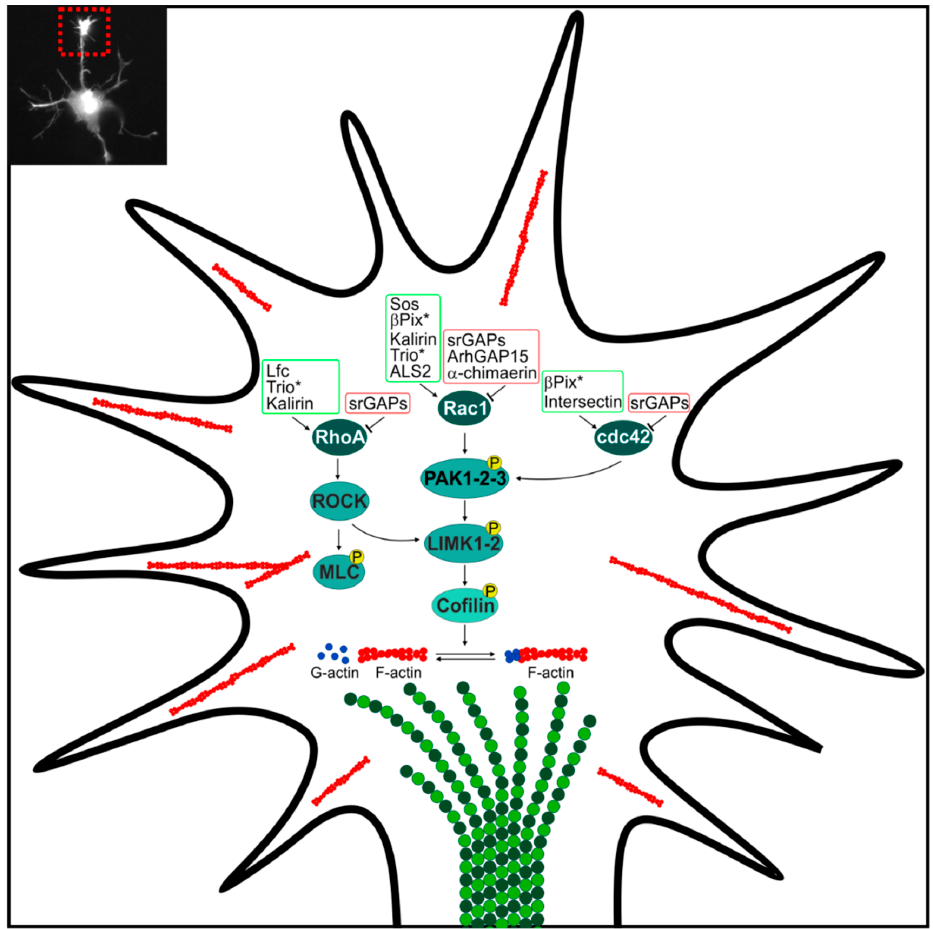
Figure 1. Regulations of Rho GTPases at the growth cone, by GTPase-activating proteins (GAPs) and Guanine nucleotide Exchange Factors (GEFs) implicated in Intellectual Disability. Green and red boxes surround GEF and GAP proteins, respectively. Asterisks indicate that are mutated in Intellectual Disability (ID) and other human diseases comprising ID. Circled P indicates phosphorylation. Arrows indicate activation, T bars indicate inhibition. A representative small magnification image of a growth cone is provided in the inset (top left). ROCK, Rho kinase-LIM domain kinase; MLC, myosin light chain; PAK1-2-3, p21-activated kinase 1-2-3; LIMK1-2, Rho kinase-LIM domain kinase 1-2.